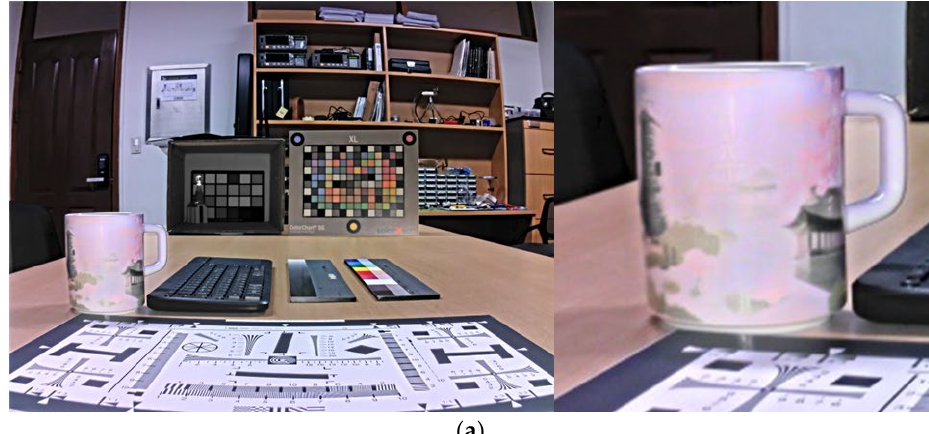
Figure 11. Sequence of image switching capturing with IR flash.